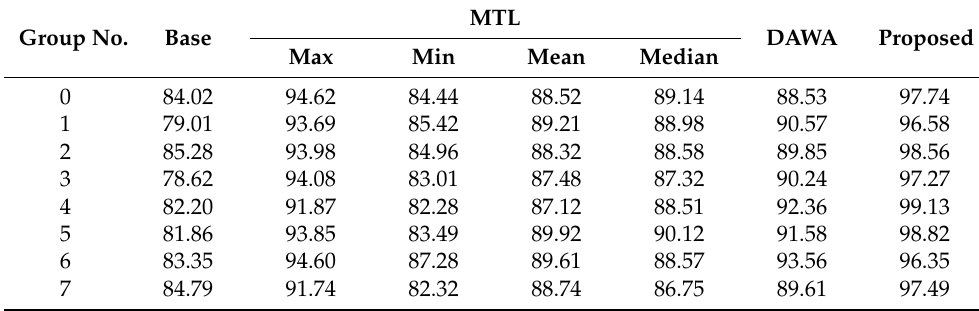
Table 4. Experimental verification among the four types of methods. Group No. Base